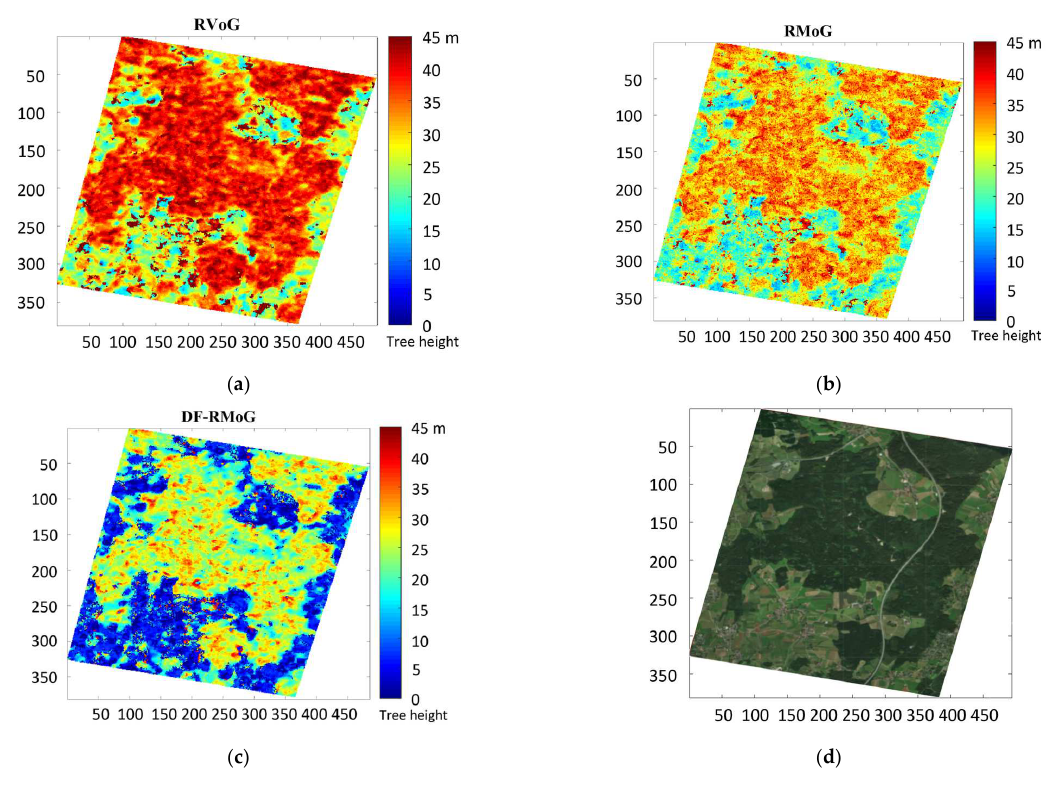
Figure 8. Forest height maps derived from different models (temporal baseline of 46 days): ( a ) RVoG. ( b ) RMoG. ( c ) DF-RMoG. ( d ) Optical image of the study site (image © 2019 Google).